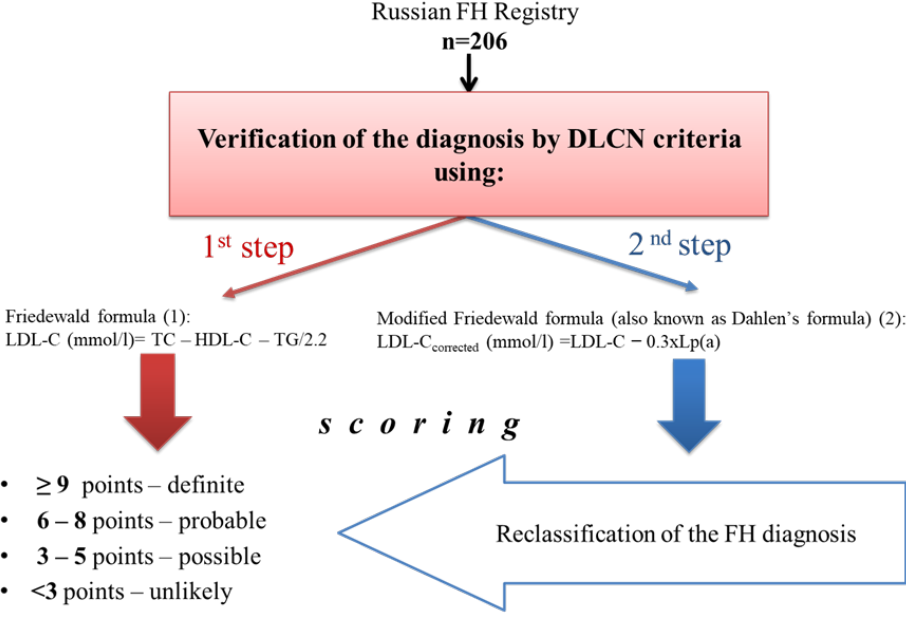
Figure 1. Study Figure 1. Study design.